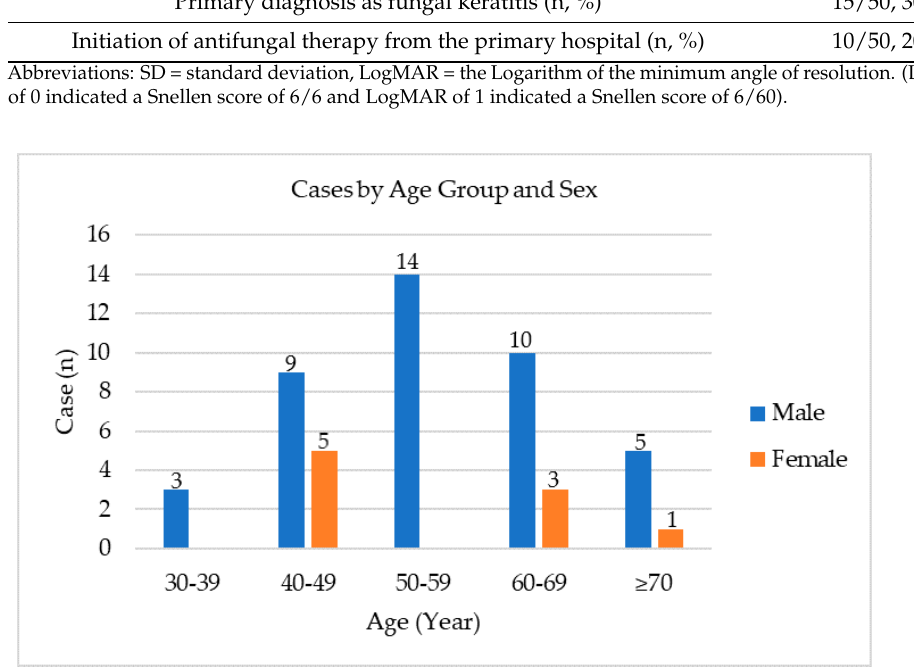
Figure 1. Distribution of dematiaceous fungal keratitis cases by age group and sex.